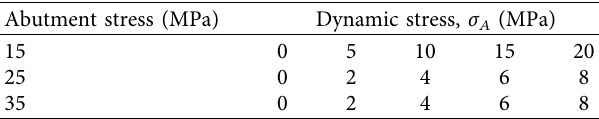
Figure 5: Comparison between the measured and simulated displacement. Table 3: Simulation